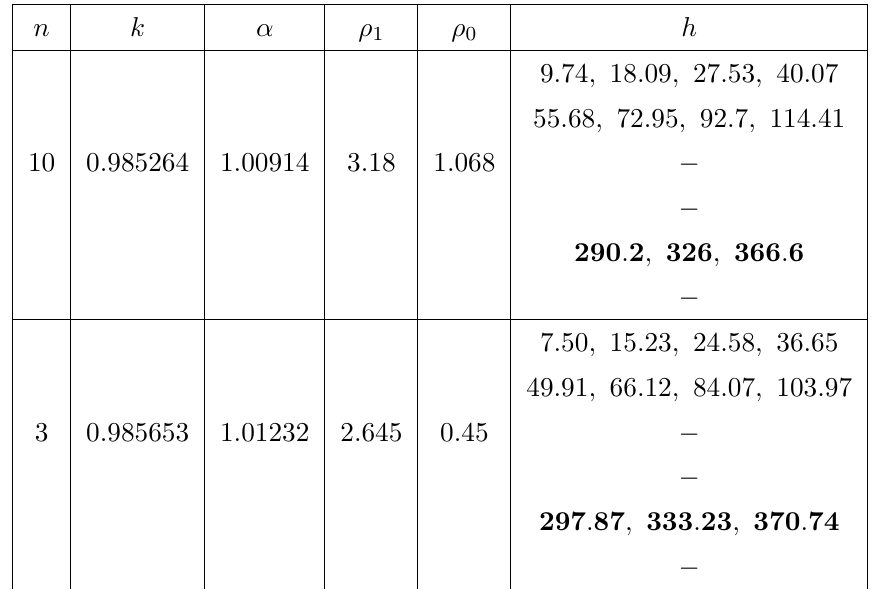
Table 1. Values of the parameters and eigenvalues for two di(cid:11)erent cases.